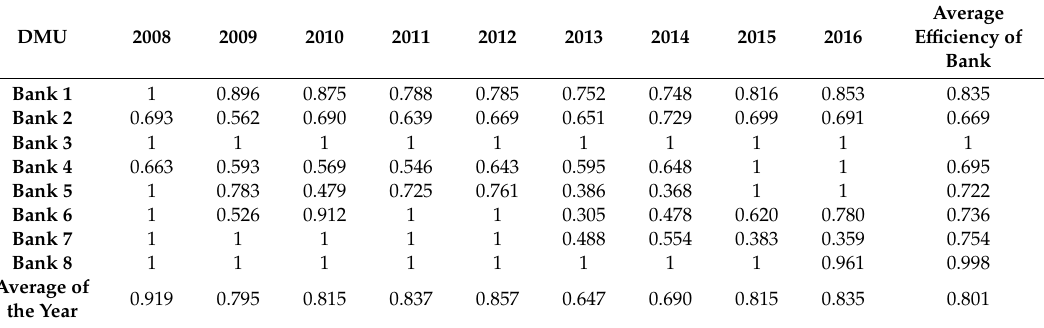
Table 11. Results of DEA model 3 (output oriented, VRS, output Mortgage Credits, input: Mortgage Bonds and Deposits).